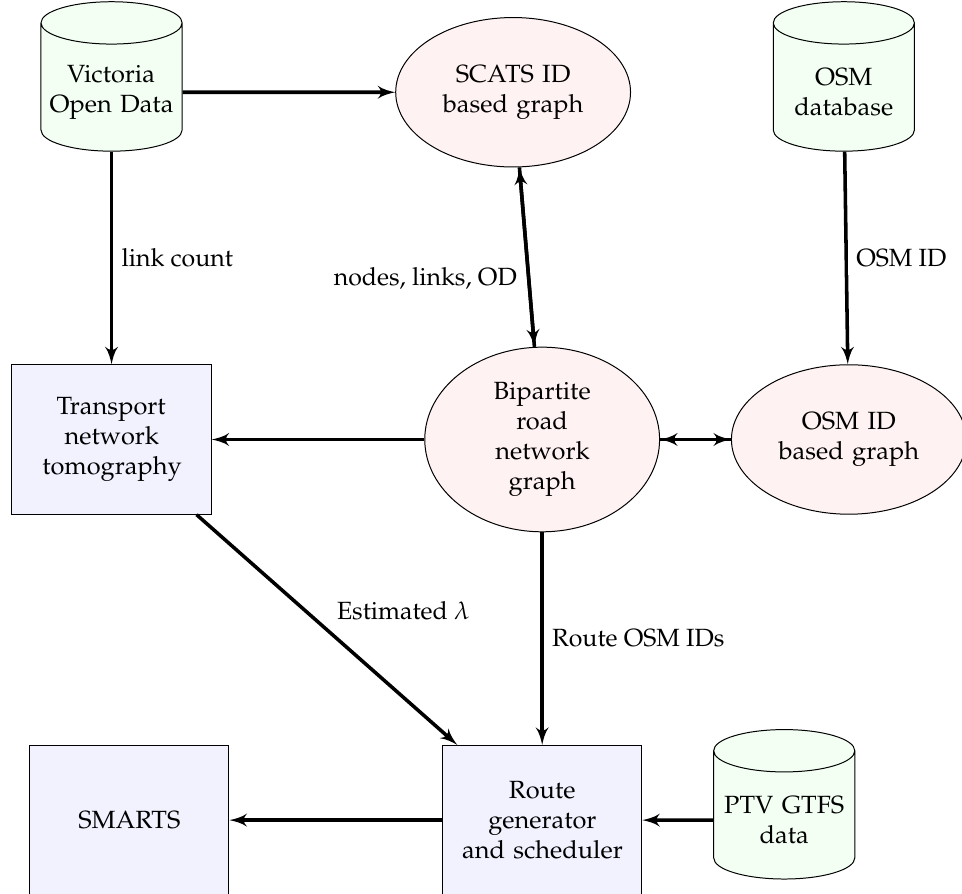
Figure 5. Flow diagram of the implementation methodology for OD flow